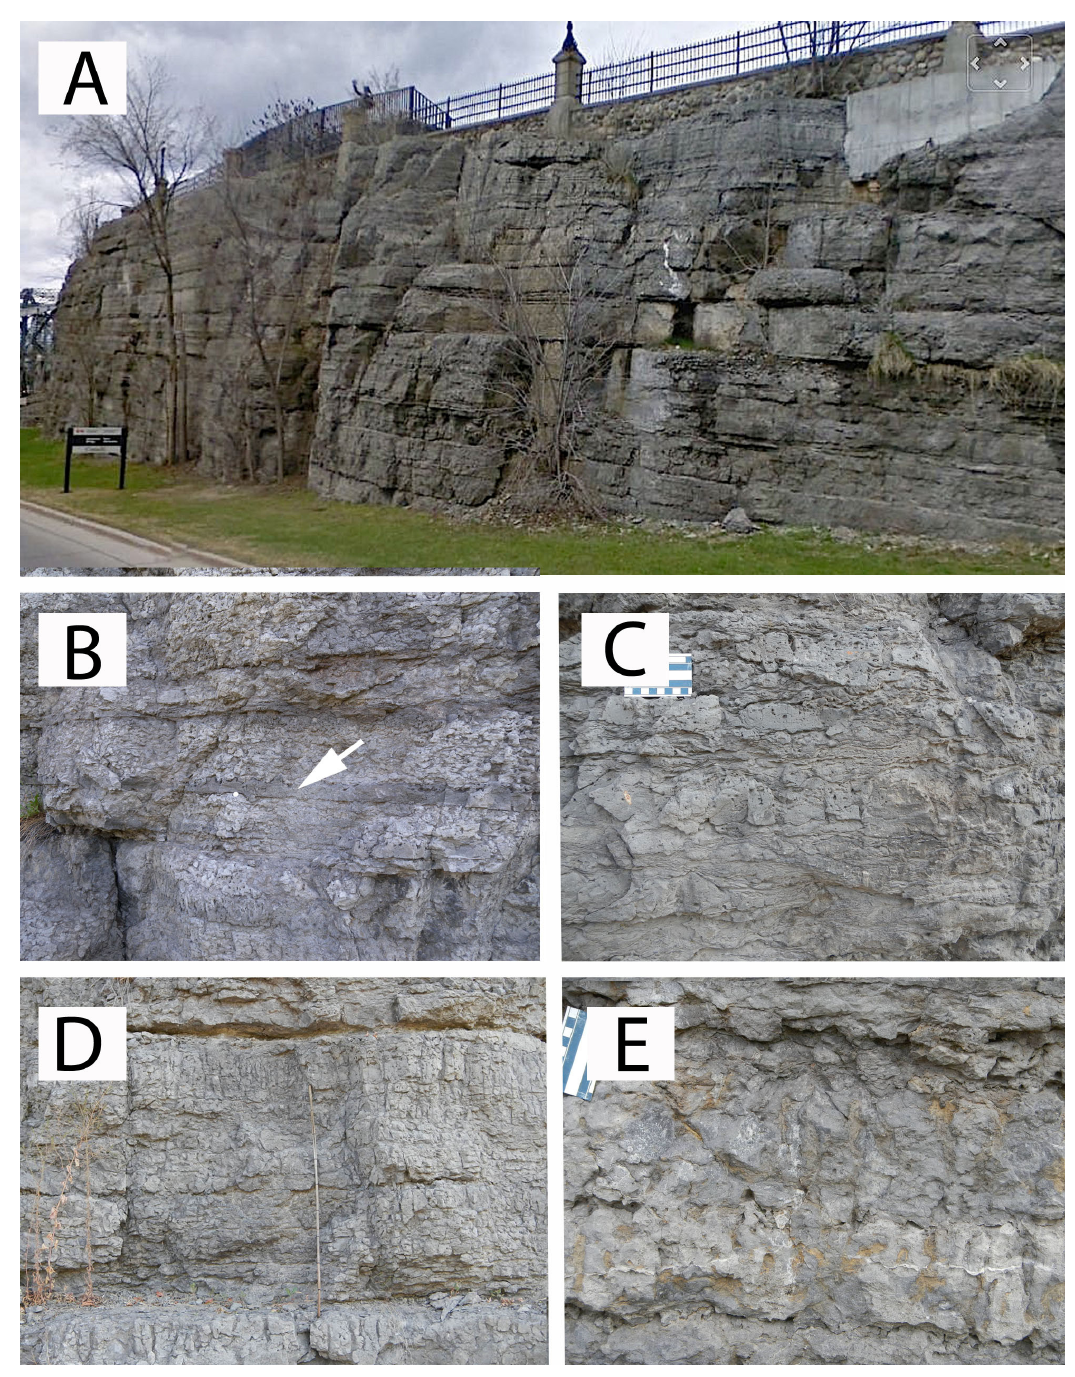
Figure 8. Facies character of the Nepean Point Member stratotype (Locality 2). ( A ) View of the middle part of the section highlighting the apparent metre-scale stratification. Vertical view is about 10 m. ( B ) Nodular facies C3a with intervening thin bed (arrow) of facies C3c that is about 10 cm thick. ( C ) Thin laminated skeletal-rich beds (facies C3c) terminating laterally within the nodular facies, C3. Some burrows extend down from the tops of the thin beds. Scale card is marked in centimetres. ( D ) Well-developed vertical burrows in packstone; measuring rod is 1.2 m long. ( E ) 3-dimensional burrow networks in wackstone (facies 2) highlighted (yellowish brown) by presence of weathered dolomite and silt-size siliciclastics. Scale card is marked in